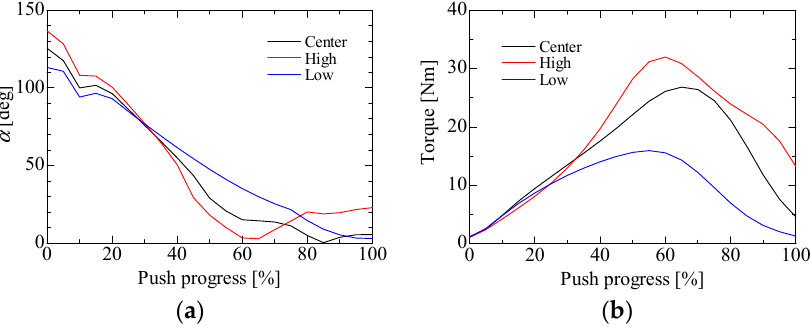
Figure 4. These figures show the simulation results of time histories of ( a ) α and ( b )